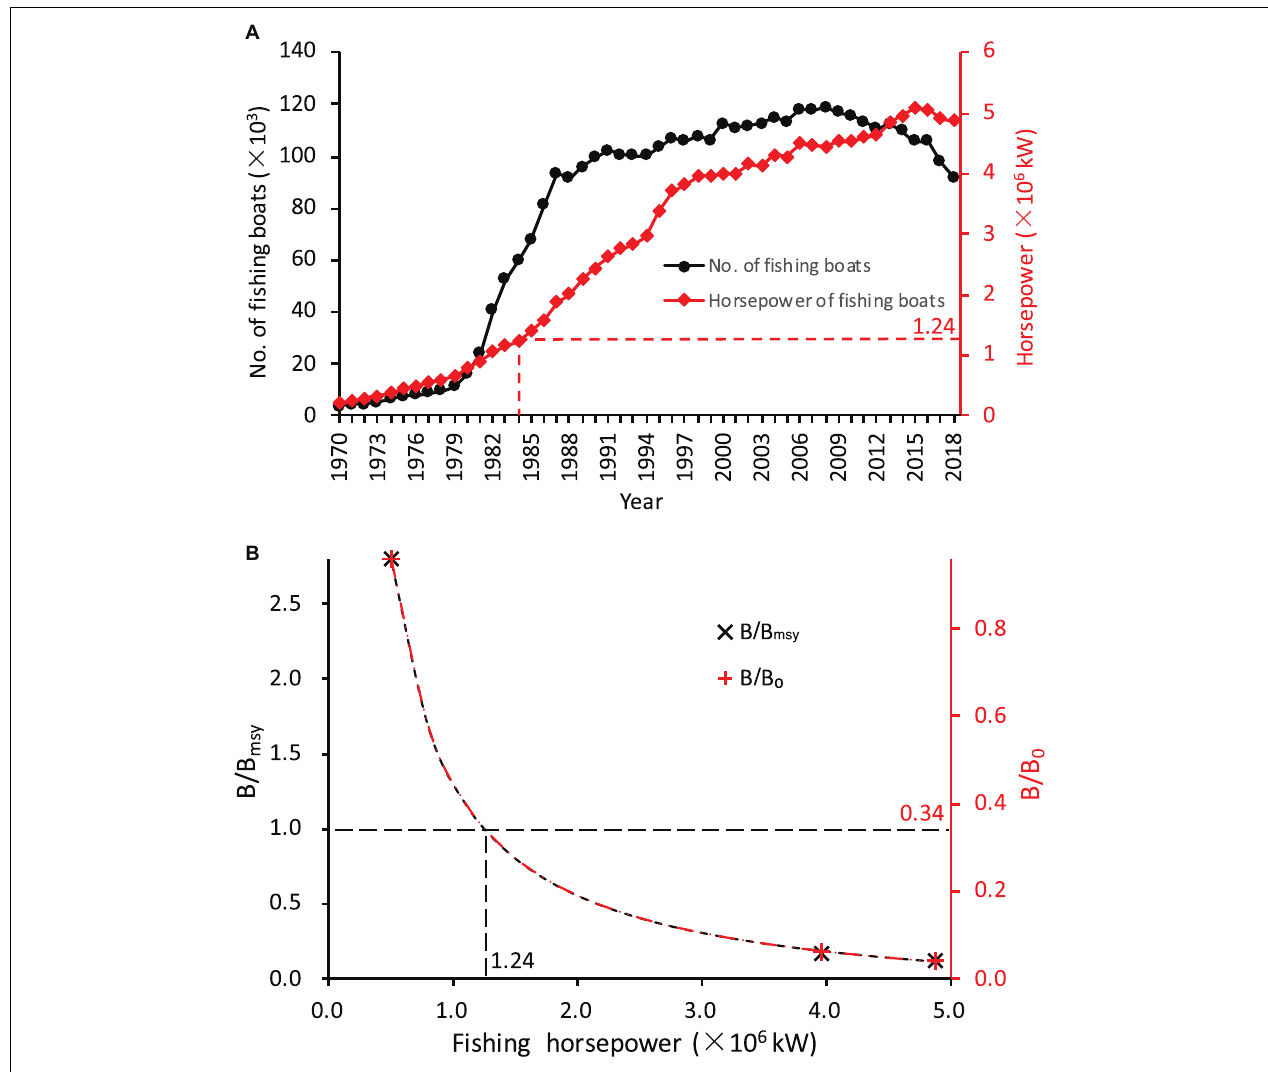
FIGURE 3 | Growth in fishing intensity and its impact on relative biomass of the miter squid stock. (A) Growth in marine motorized fishing boats from the Fujian and Guangdong Provinces from 1970 to 2018 [data from China Fishery Statistical Yearbook (Fishery Management Bureau of Ministry of Agriculture and Rural Affair (FMBMARA), 1970–2018)]. (B) Decline of relative biomass ( B /B msy and B / B 0 ) with increasing fishing horsepower; B = B msy corresponds to B = 0.34 B 0 and fishing horsepower level of 1.24 × 10 6 kW in